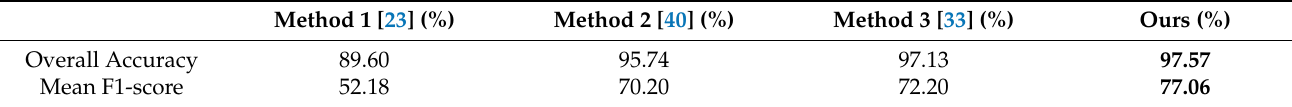
Table 4. Overall accuracy of different methods in the Paris-rue-Cassette dataset.